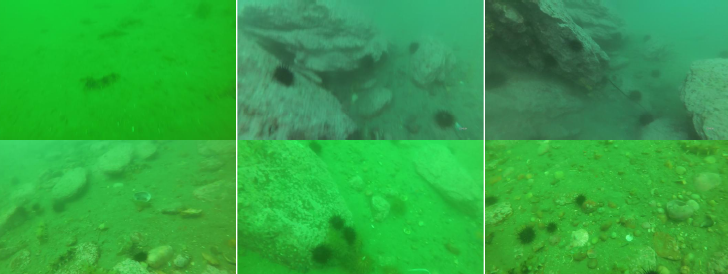
Figure 6. Degraded underwater images in URPC2018. Images taken underwater usually present severe degradation because of the light window effect and the light scatter